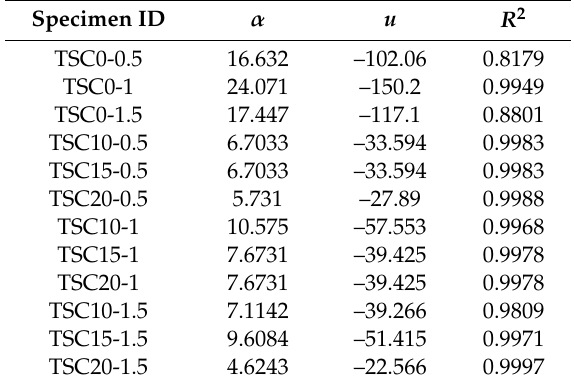
Figure 11. Weibull distribution of steel wires and tire rubber for the TSC specimens. Table 3. Shape, scale parameters and coefficient of determination of the TSC specimens.